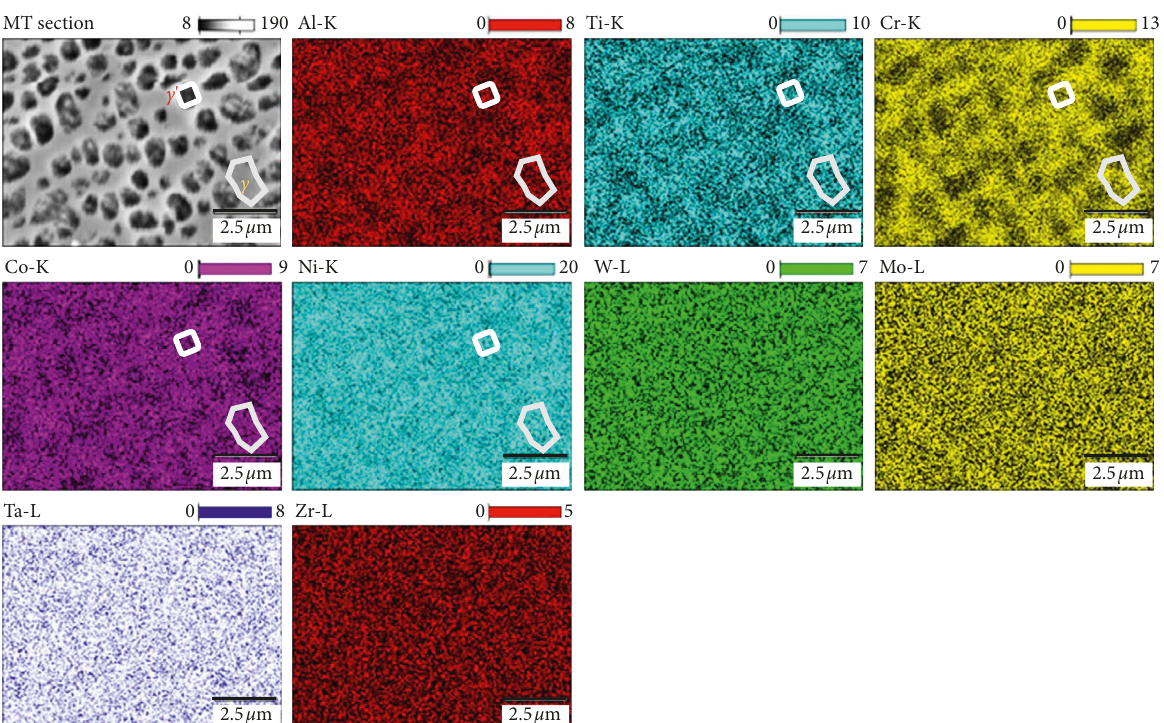
Figure 5: Element-imaging SEM analysis of IN-792 superalloy for MT section.